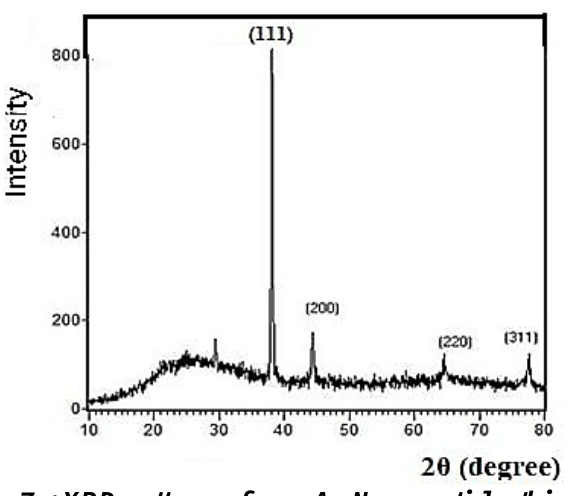
Figure 7a: XRD patterns of pure Ag Nanoparticles thin